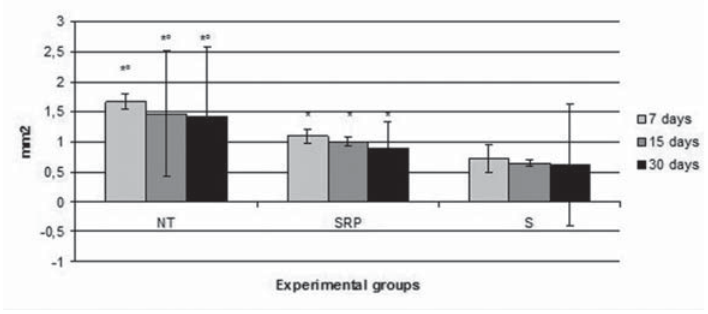
Figure 3- Means and standard deviations (M±SD) of hypsometric data PO (mm 2 (cid:12)(cid:3)(cid:76)(cid:81)(cid:3)(cid:87)(cid:75)(cid:72)(cid:3)(cid:73)(cid:88)(cid:85)(cid:70)(cid:68)(cid:87)(cid:76)(cid:82)(cid:81)(cid:3)(cid:85)(cid:72)(cid:74)(cid:76)(cid:82)(cid:81)(cid:3)(cid:82)(cid:73)(cid:3)(cid:87)(cid:75)(cid:72)(cid:3)(cid:79)(cid:72)(cid:73)(cid:87)(cid:3)(cid:191)(cid:85)(cid:86)(cid:87)(cid:3)(cid:80)(cid:82)(cid:79)(cid:68)(cid:85)(cid:86)(cid:15)(cid:3)(cid:68)(cid:70)(cid:70)(cid:82)(cid:85)(cid:71)(cid:76)(cid:81)(cid:74)(cid:3) to each group and